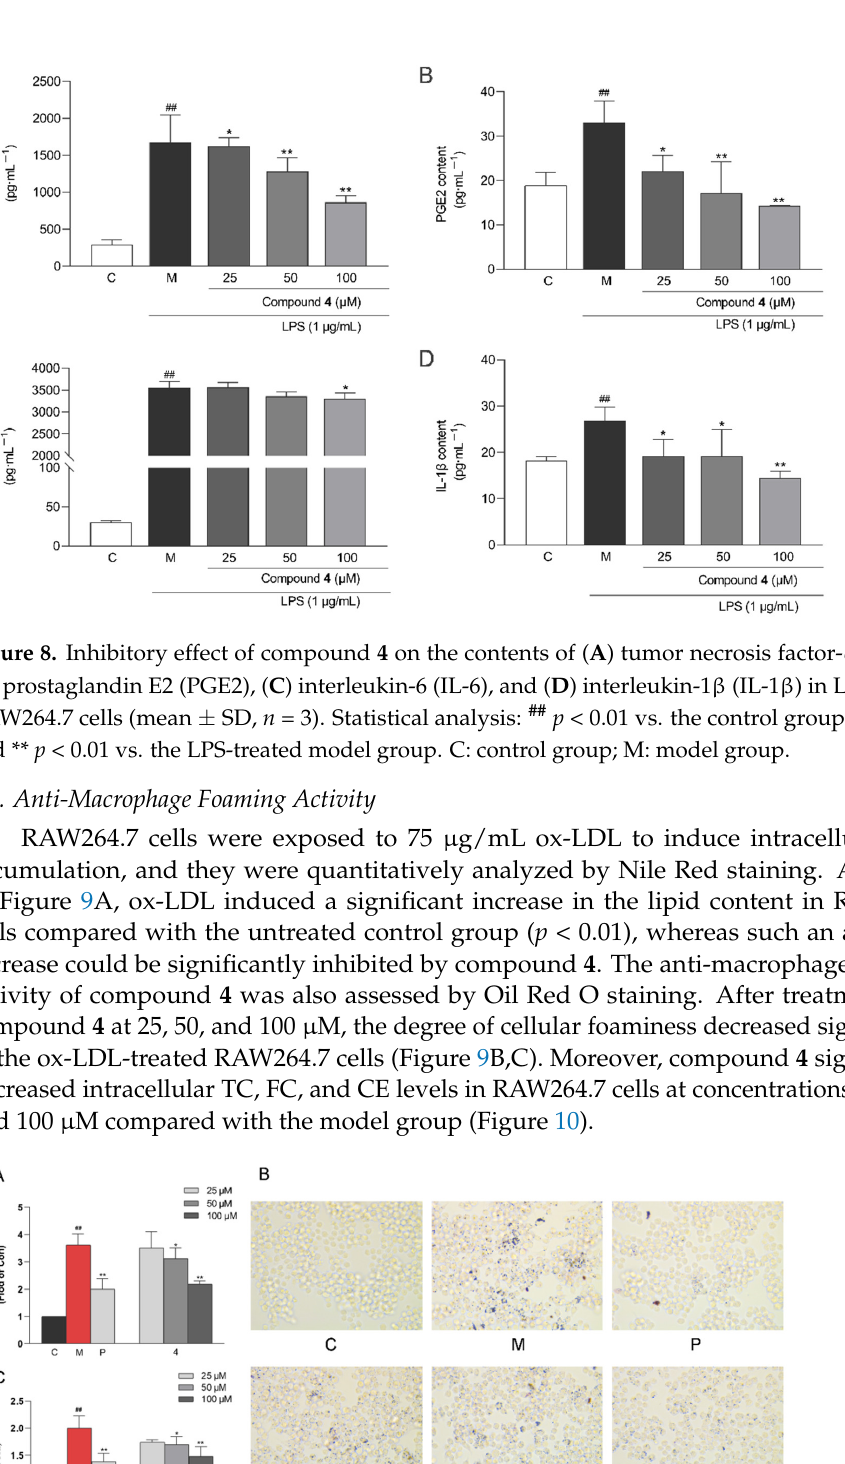
Figure 7. Inhibitory effects of compounds 2 – 5, 7 , and 8 on lipopolysaccharide (LPS)-induced NO production in RAW264.7 cells. ( A ) Relative NO content in RAW264.7 cells of each group. ( B ) The inhibition rates of LPS-induced NO production by the compounds (mean ± SD, n = 3). Statistical analysis: ## p < 0.01 vs. the control group; * p < 0.05; and ** p < 0.01 vs. the LPS-treated model group. C: control group, M: model group, and P: positive group.